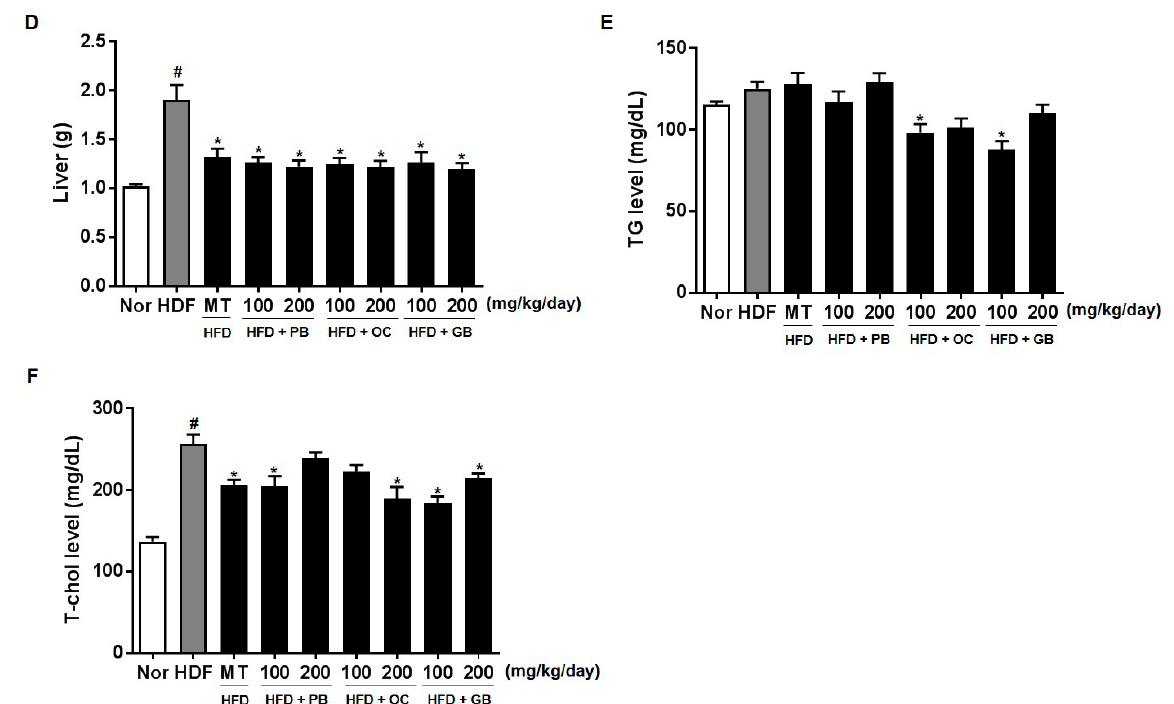
Figure 2. Effects of PB, OC, and GB extracts on mouse liver histology and body weight in a high-fat diet (HFD)-fed mouse model. ( A ) Photographs of the mouse liver. ( B ) Histopathological examination by hematoxylin and eosin (H&E) (liver and epididymis fat tissue) and Oil Red O (liver) staining and ( C ) body weights are shown for HFD-fed mice, with or without PB, OC, and GB extract supplementation. Liver weights ( D ), TG levels ( E ), and total cholesterol (TC) levels ( F ) in the liver tissues from the mice treated with the PB, OC, and GB extracts. MT, milk thistle. The data are presented as the mean ± SEM ( n = 9); # p < 0.05 compared with the control group; * p < 0.05 compared with the HFD group.